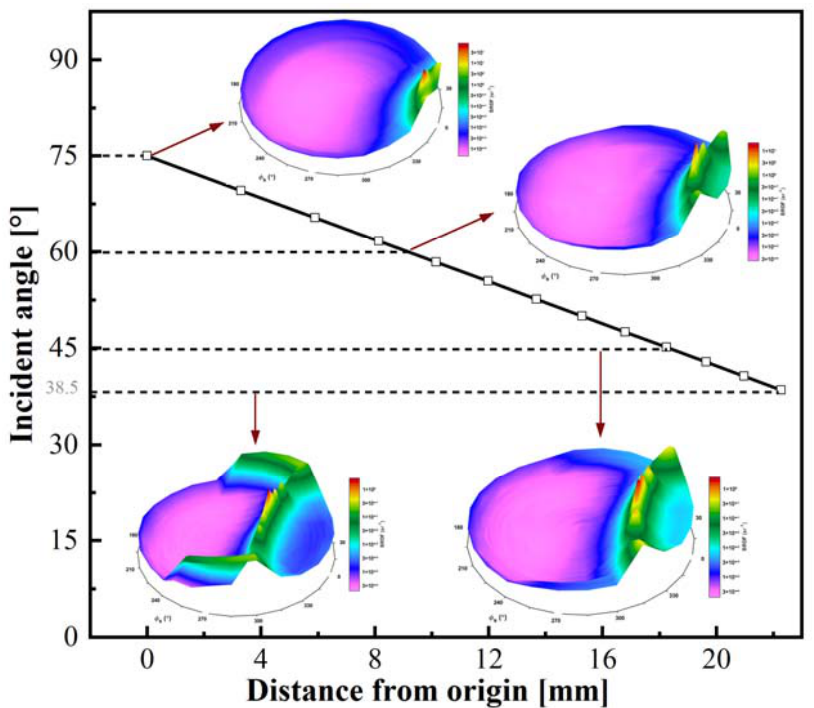
Figure 5. The variation of reflection pattern and inclination angle α r in a different